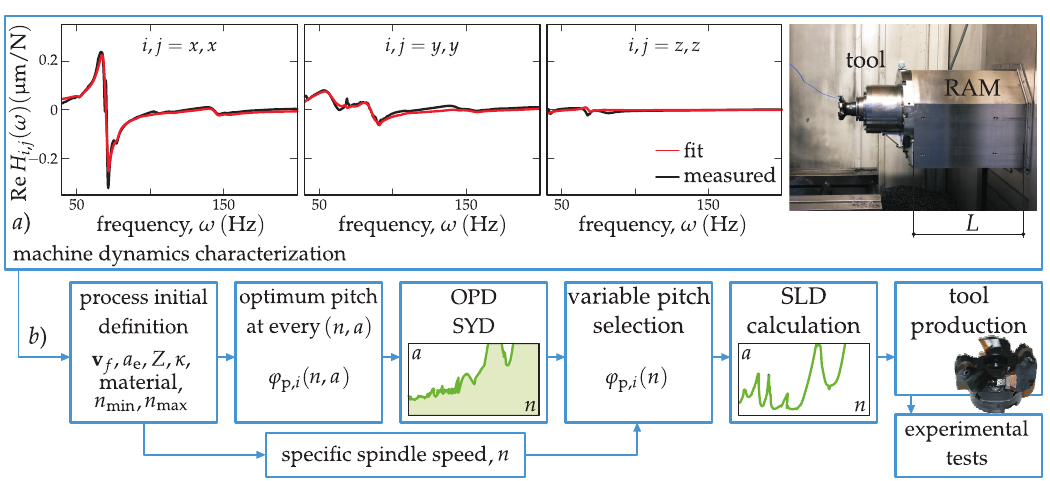
Figure 3. ( a ) Machine dynamics characterization; ( b ) flowchart of the procedure for calculation of the optimal pitch